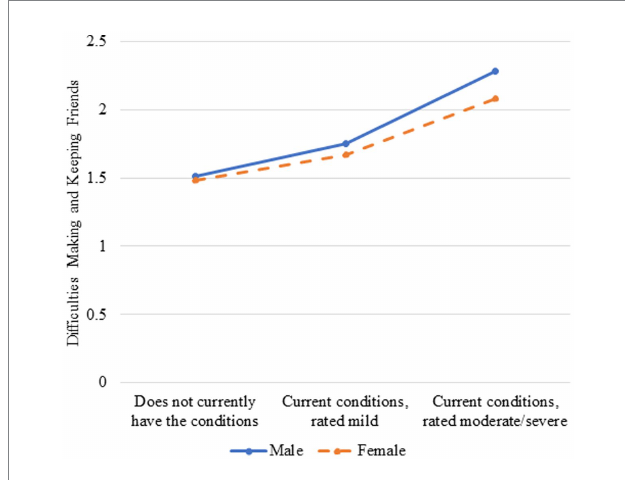
FIGURE 2 School engagement and speech-language disorder severity moderated by sex for English